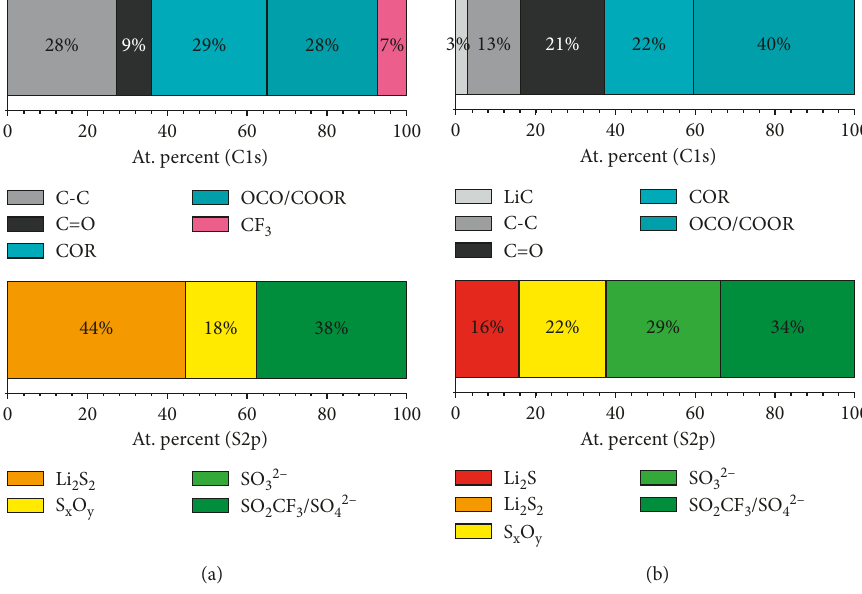
Figure 9: Relative distribution of carbon (a) and sulfur (b) containing chemical structures detected before (left) and after (right) 30 min of Ar sputtering for the SEI layers after electrochemical cycling in 1M LiTFSI, DOL : TEGDME and PS